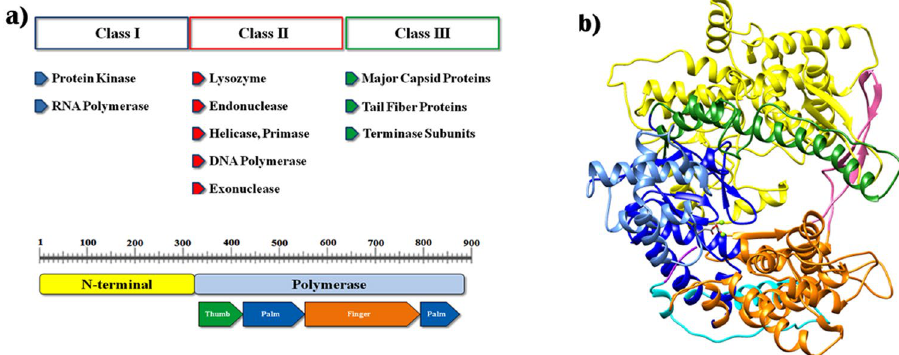
Figure 1. ( a ) Major gene products of T7 phage genome and domain architecture of T7RNAP with major sub- domains; ( b ) T7RNAP model structure: The color representation is as follows, the N-terminal domain (1–325), yellow; the thumb (326–411), green; the palm (412–449, 528–553, 785–879), dark blue; the palm insertion module (450–527), light blue; the fingers (554–739, 769–784), orange; specificity loop (740–769), pink; extended foot module (838–879), cyan; and C-terminal (880–883), violet. Two metal ions at the active site are shown as green